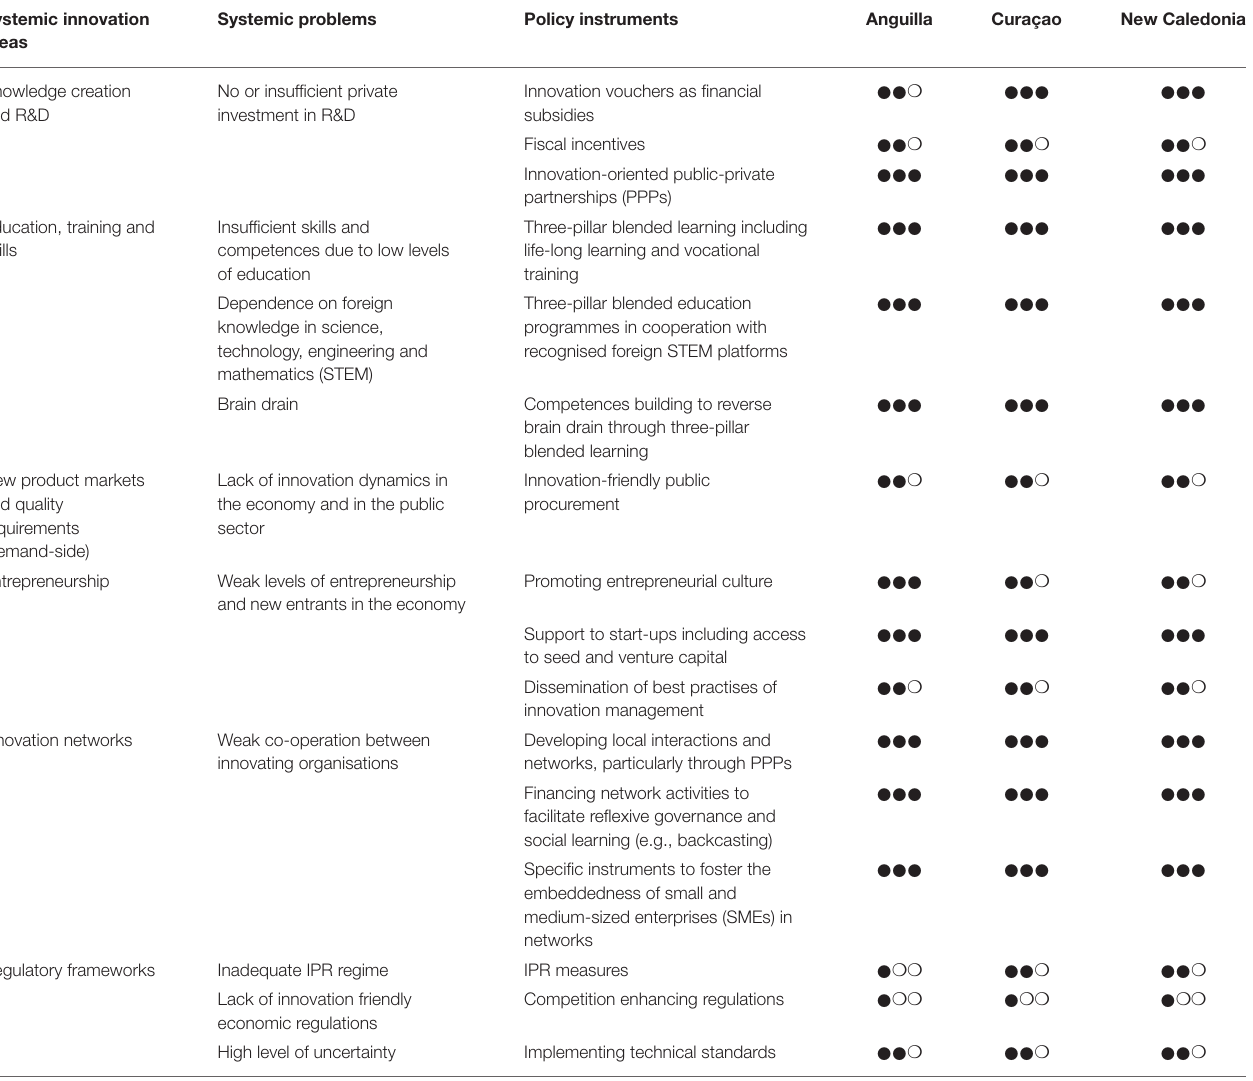
TABLE 1 | Main systemic innovation problems in the concerned OCTs and relevance of policy instruments to mitigate